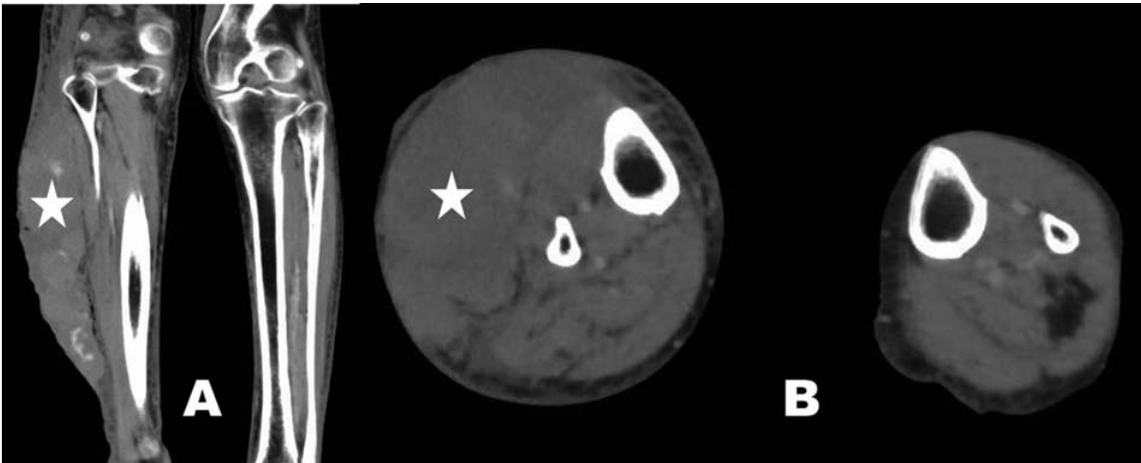
Fig. 1 Contrast-enhanced computed tomography shows a large hematoma (indicated by the star) in the right calf 6 hours after trauma; ( A ) coronal view, ( B ) axial view.